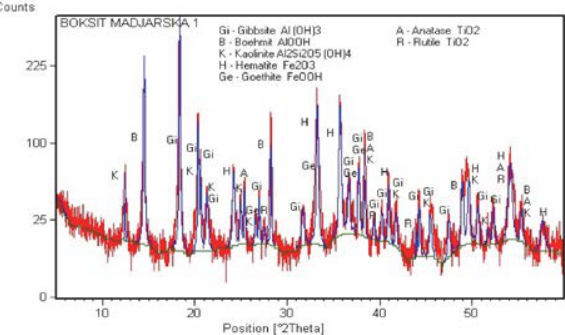
Figure 8. Diffractogram of the bauxite sample “Mađarska”